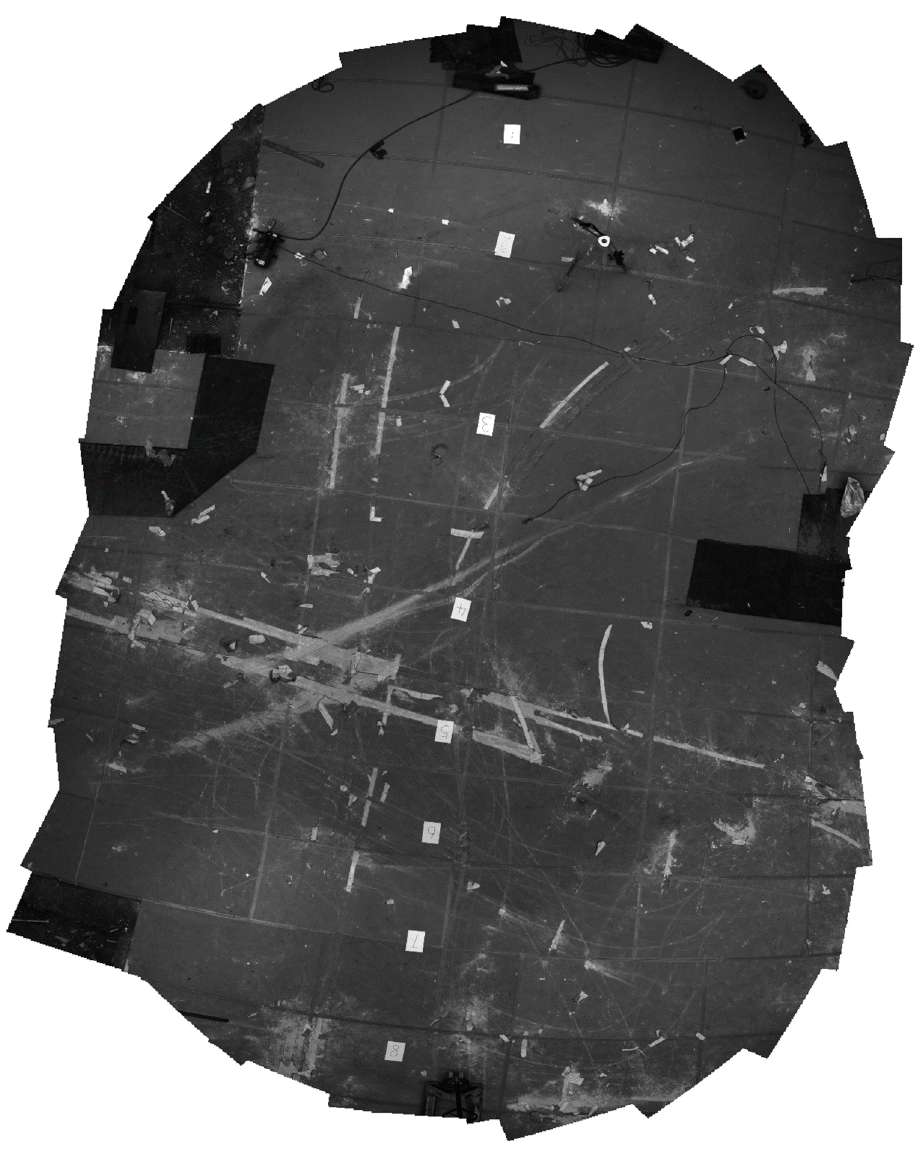
Figure 28. OCPSI mode: experimental image. Afterwards, we conducted push-broom and whisk-broom ground experiments with the same experimental equipment and experimental conditions. Figures 30 and 31 are experimental images. The width of the push-broom is 1.64 m, and a part of the overlap is required to ensure complete coverage. To achieve the width of the OCPSI mode, at least seven tracks are required. When the whisk-broom mode adopts the same whisk-broom half-cycle frame number as the OCPSI mode and the number of frames is three frames, the whisk-broom width is 3.83 m, and at least three tracks are required to achieve the width of the OCPSI